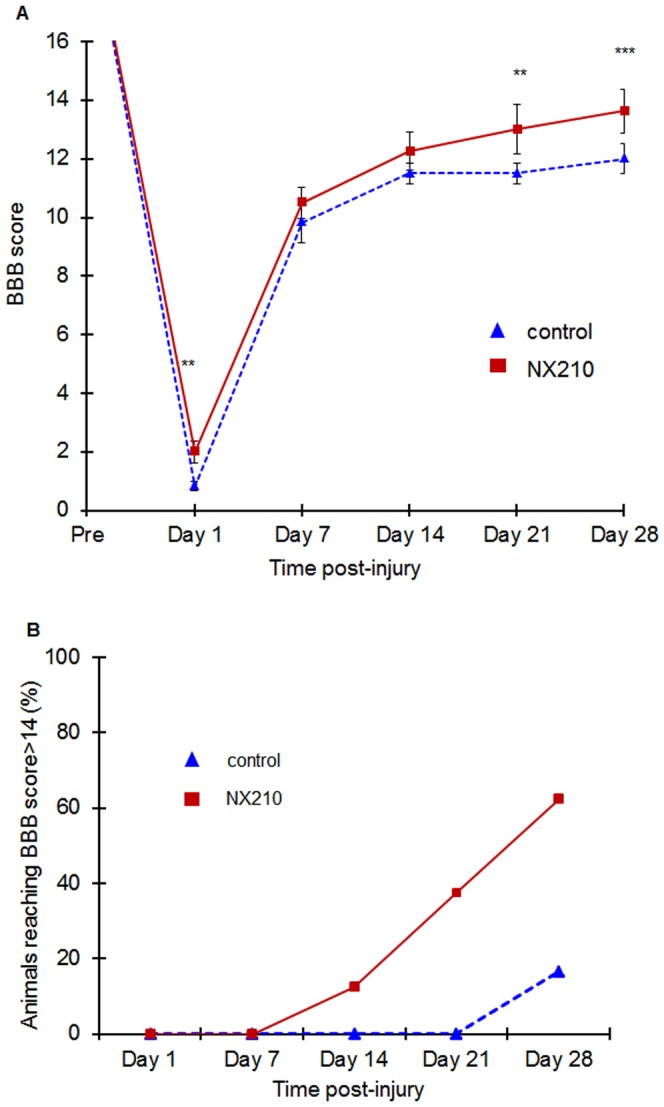
Effects of NX210 on functional recovery after SCI: BBB score.Functional recovery was assessed once a week over the month of the study using the open-field locomotion test and the BBB score. NX210-treated group (n = 8) in solid red line, vehicle group (n = 8) in blue dashed line. (A) The NX210-treated group BBB score was significantly higher in the last two weeks of observation compared to the vehicle group. BBB score continues to improve at the end of the study whereas in the control group, the BBB does not significantly improve from D14 to the end of the study. (B) The percentage of animals reaching a score superior to 14, corresponds to a complete forelimb – hind limb coordination. In the NX210-treated group, the animals reached a score >14 as early as the second week post-injury. The number of animals reaching a BBB score of 14 continuously increases until the end of the study reaching 62% of the NX210-treated group. In the vehicle-treated group, a score>14 is reached by only one animal at the fourth week post-injury. Data are presented as mean ± SEM, p<0.05.